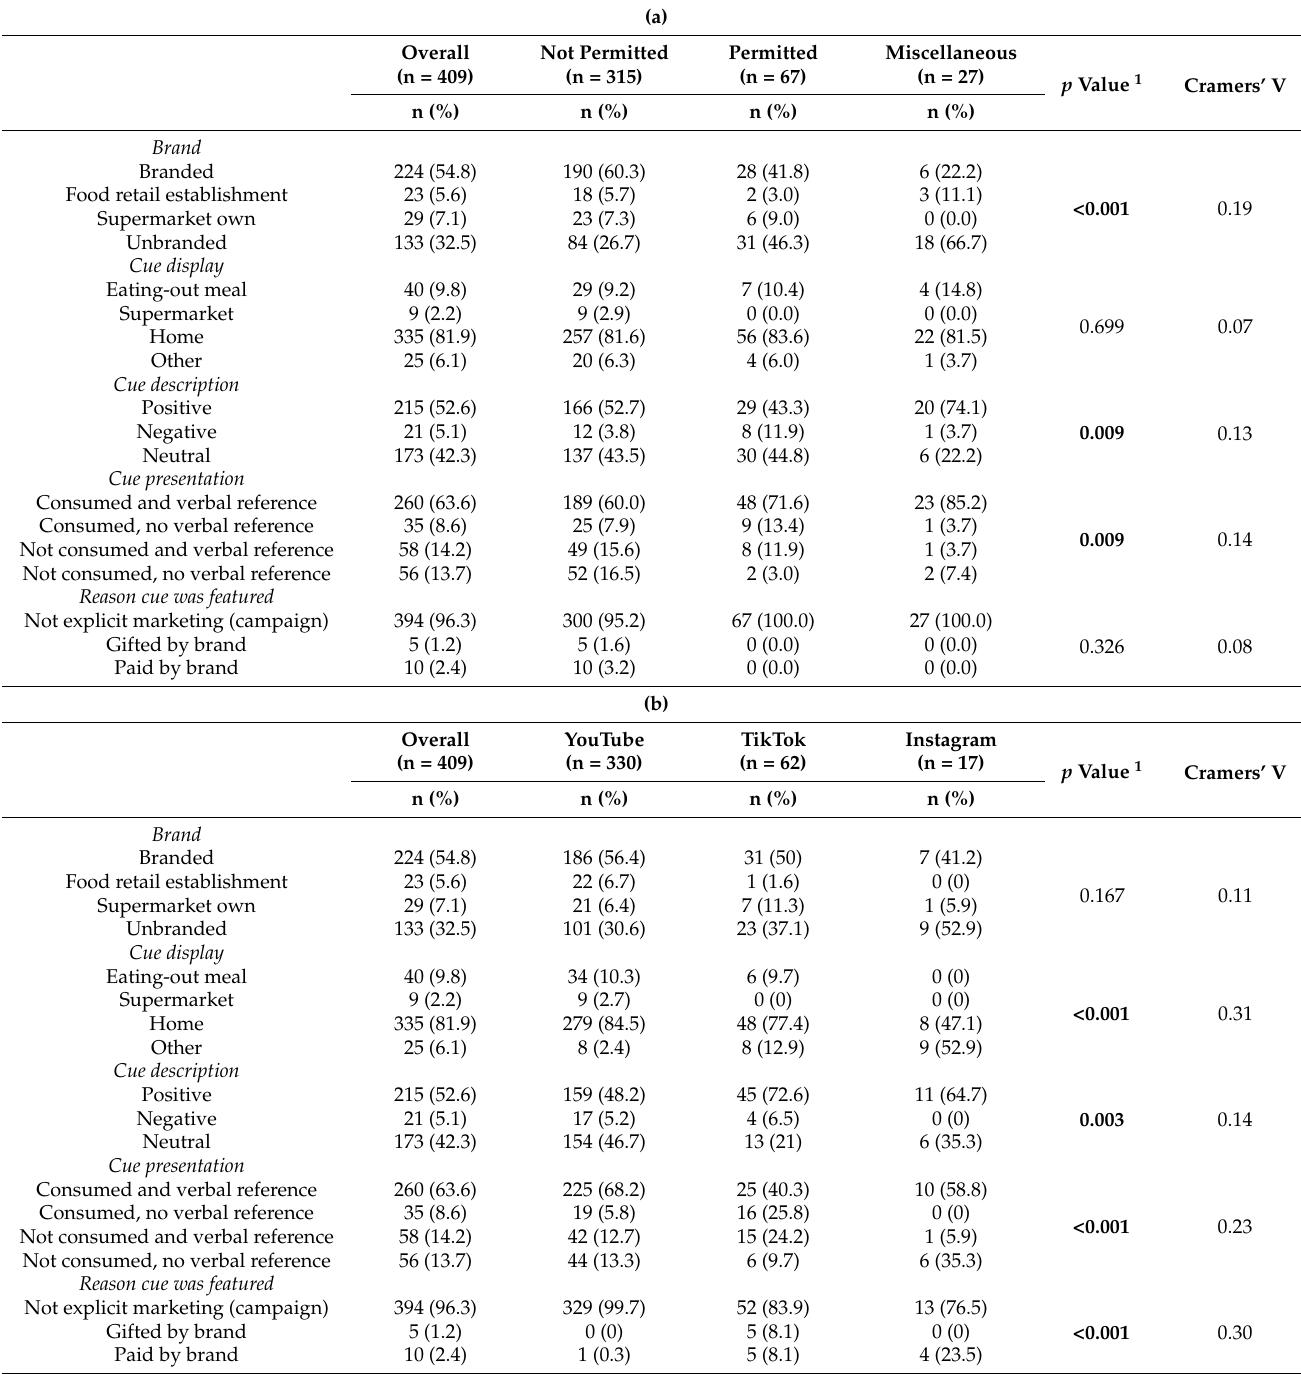
Table 2. ( a ). Food and beverage cues’ brands, displays, description, and presentation, split by category according to the WHO Nutrient Profiling Model. ( b ). Food and beverage cues’ brands, displays, description, and presentation, split by category between the